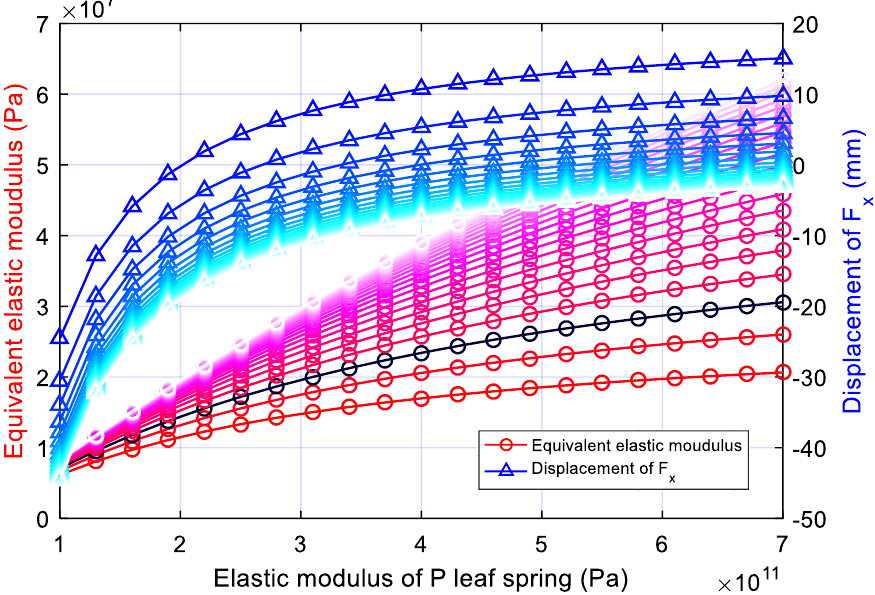
Figure 6. Effect of different Ep and Eq on the equivalent elastic modulus and x -direction displacement ( F 𝑥 ) of the bionic leg 3.3. Influence of Initial Length to 𝐸̅, 𝐹 𝑥 of the Ostrich-Like Leg The initial length is adjusted by the angle at points M and N. The effect of the initial length of the spring leg on 𝐸̅, F 𝑥 . 𝐸̅ increases with the initial length, and the variation rate also increases with the initial length. This rule allows us to adjust the length of the leg on the appropriate premise so that the leg can store more energy during impact. F 𝑥 decreases first and then increases with the increase of the initial length. The lowest extreme point is located at about 840 mm (Figure 7). Therefore, the leg length should be set near this value, at which the shaking of the upper body during locomotion turns out to be the least, in theory. In order to eliminate the interference of randomly selected compressive force on the above conclusions, The variation law of 𝐸̅ and F 𝑥 is obtained under different initial lengths and loads, as shown in Figure 8. 𝐸̅ increases with the increment of compressive force in a static equilibrium state at the same initial length, and the increment of the elastic modulus increases monotonously. F 𝑥 also increases with the compression force, and the increment is the largest when the initial height is about 840 mm, while F 𝑥 first decreases and then increases with compressive force when the initial height is about 680 mm.